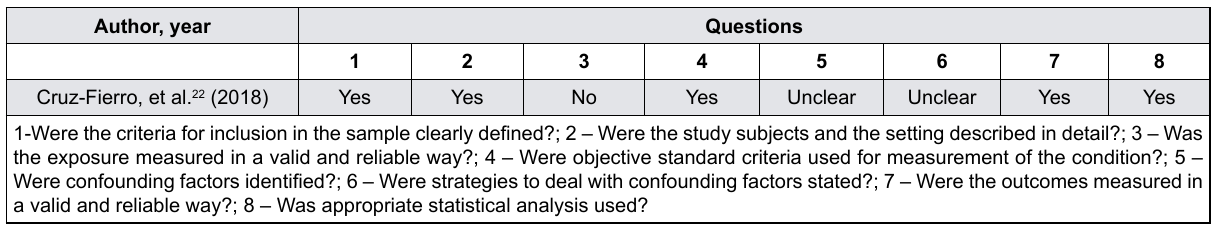
Figure 5- JBI Critical Appraisal Checklist for Analytical Cross-Sectional for Analytical Cross-Sectional Studies Cruz-Fierro, et al. 22 (2018) presented five positive responses (Figure 5).